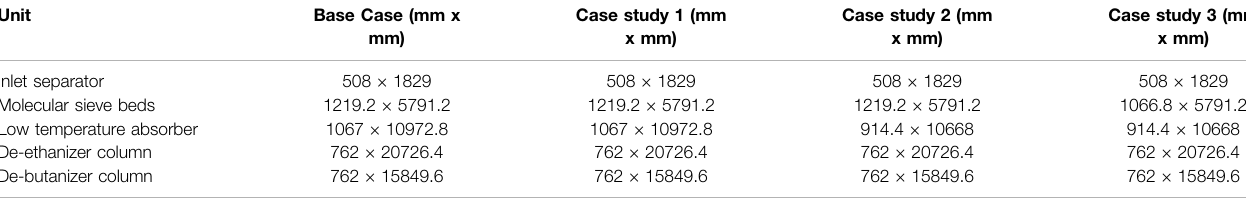
TABLE 3 | Size speci fi cation of the process units of different case studies for LPG recovery. Unit